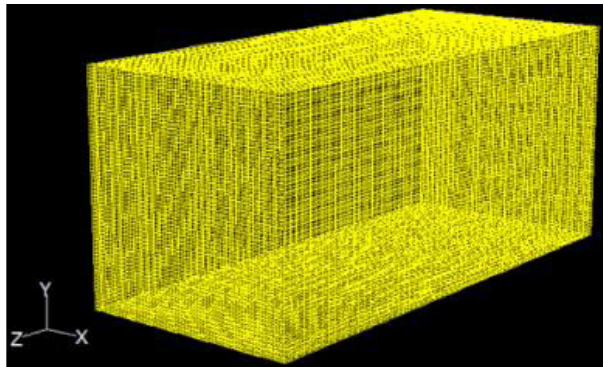
Fig. 3. Grid for vertical square enclosure